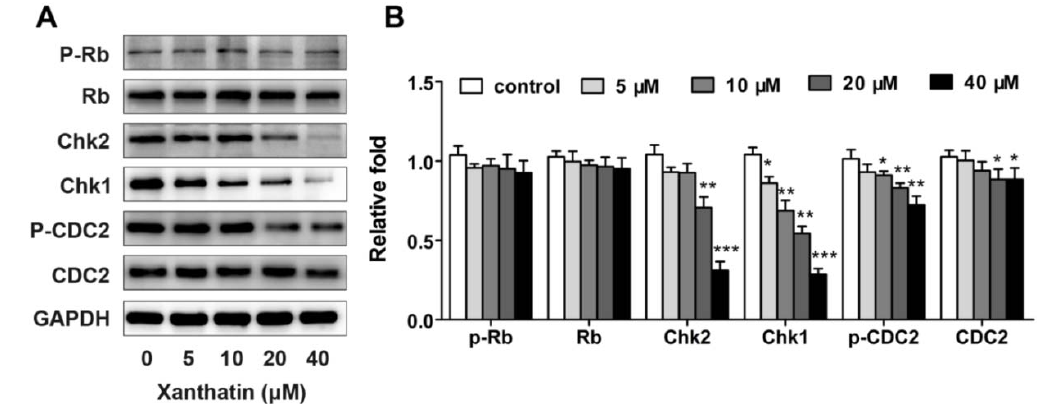
Figure 3. Western blot analysis of cell cycle-related proteins in A549 cells treated with xanthatin. ( A ) The protein levels of G2/M cell cycle regulatory molecules including P-Rb, Rb, chk1, chk2, CDC2, p-CDC2 in A549 cells treated with xanthatin at indicated concentrations for 24 h were analyzed by western blot assay; ( B ) Densitometry analysis of the protein levels of G2/M cell cycle regulatory molecules. Data were presented as means ± SD by three independent experiments. Significance: * p < 0.05 versus the control; ** p < 0.01 versus the control, *** p < 0.001 versus the